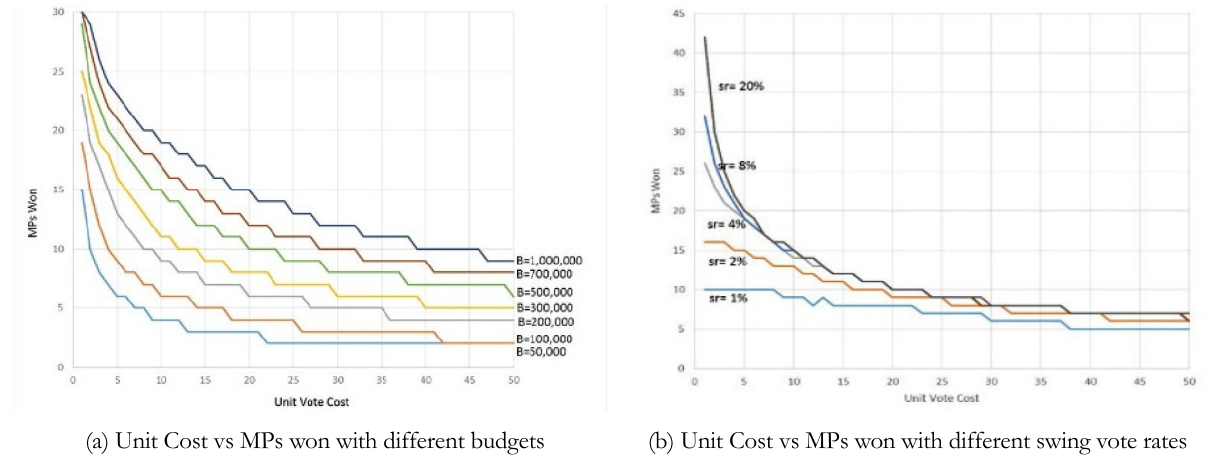
Figure 2. Effects of Unit Vote Cost on Number of MPs